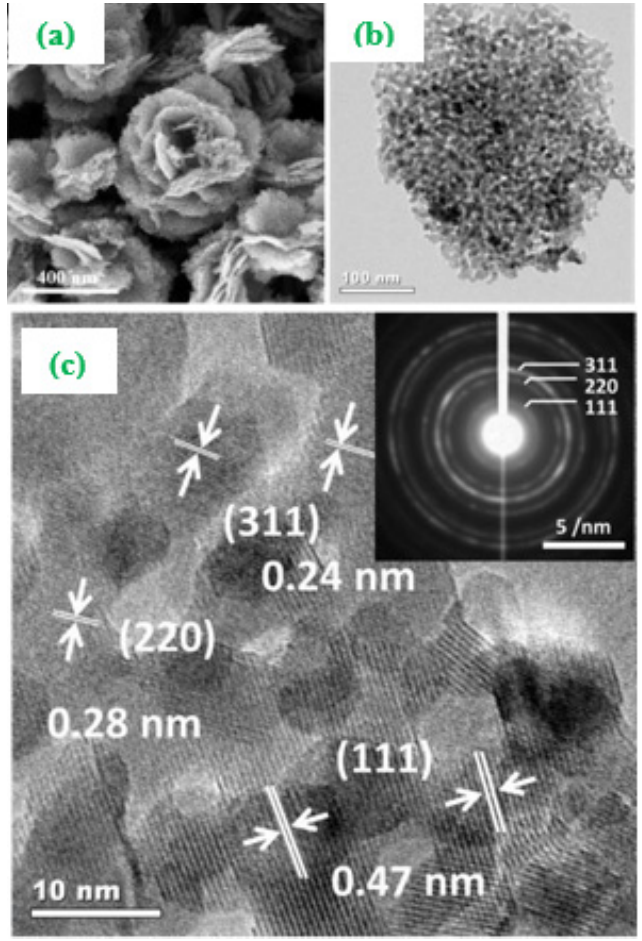
Figure 4. ( a ) SEM ( b ) TEM ( c ) HR-TEM images with an inset of SAED pattern of 20% Mn-Co. Copyright 2016 by the American Chemical Society [52].